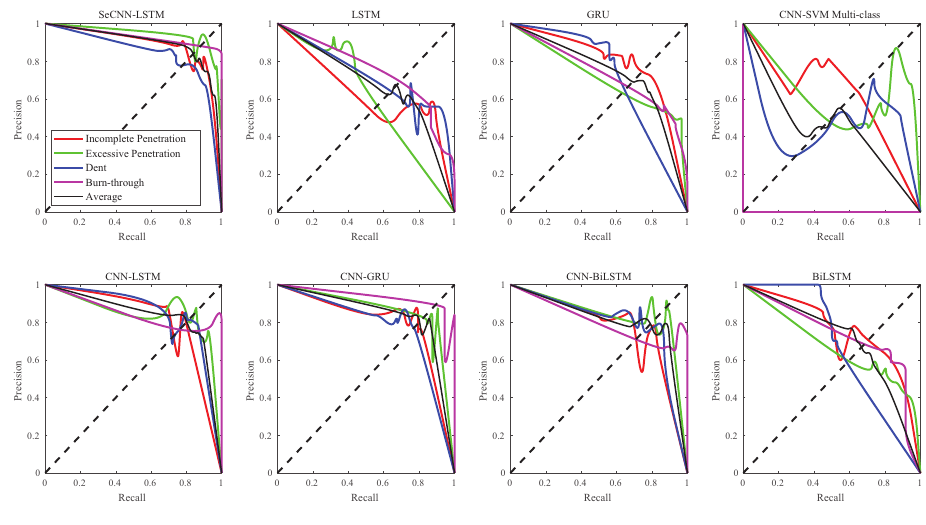
Figure 14. P–R curve comparison. The area values enclosed by the P–R curves (P–R AUCs) are shown in Table 5. The value of each sample of the SeCNN-LSTM model is above 0.83. Table 5. P–R AUC comparison.